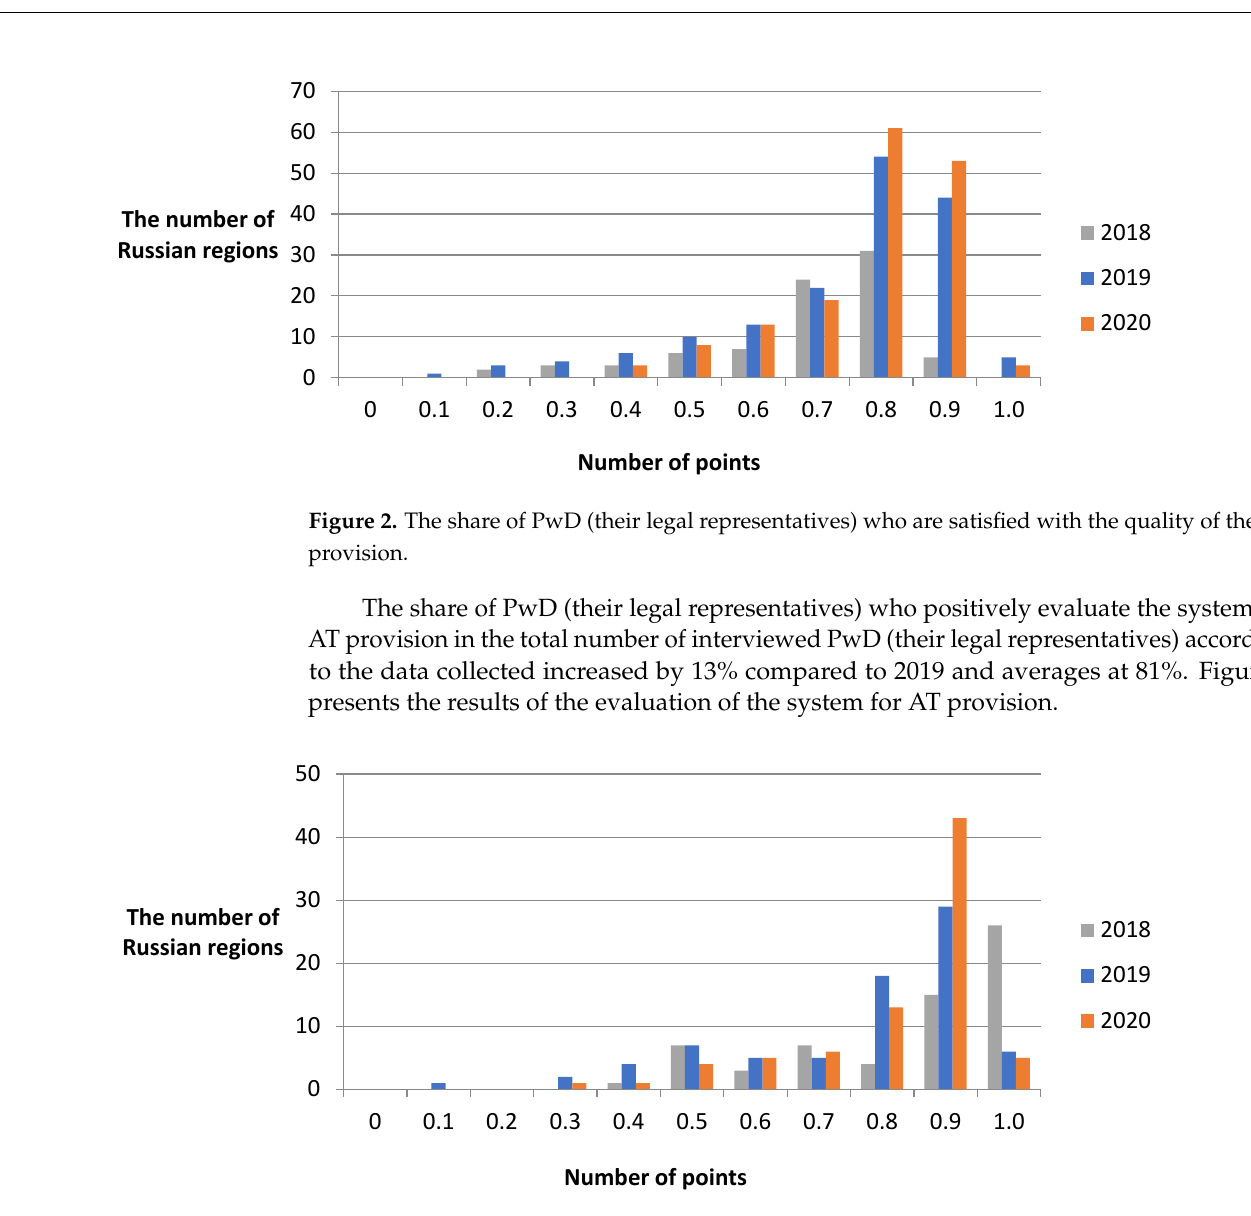
Figure 3. The share of PwD (their legal or authorised representatives) who positively evaluate the system for AT provision.